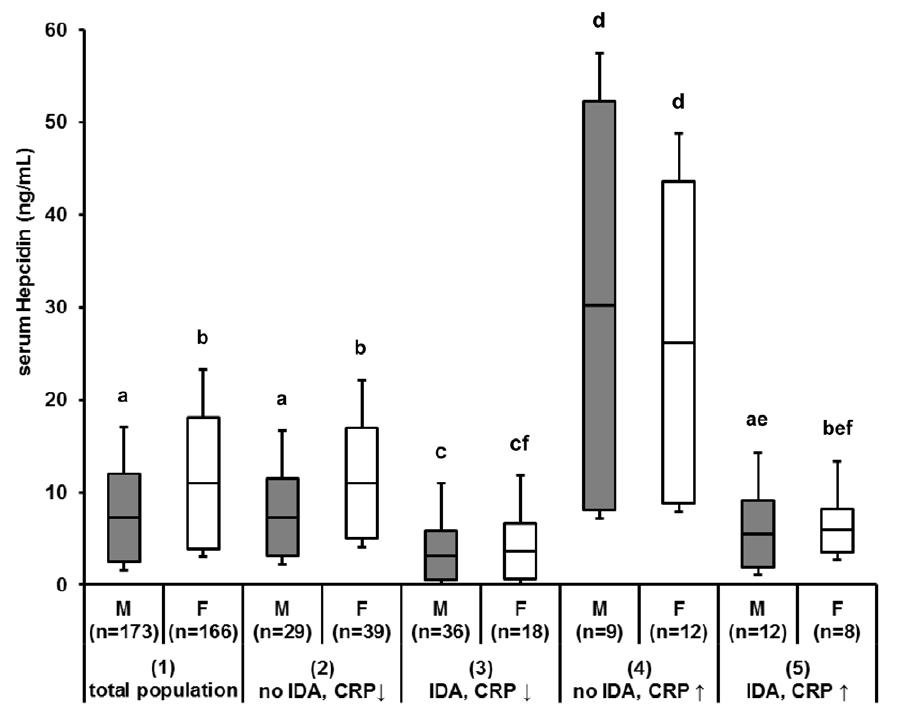
Figure 1. Median levels, lower and upper quartile plus standard error, of serum hepcidin (ng/mL) by sex, measured in different subgroups. Criteria for subgroups were as follows: ( 1 ) total population; ( 2 ) no iron deficiency (ID), no anemia, and no elevated CRP concentration; ( 3 ) ID and anemia (IDA), but no elevated CRP concentration; ( 4 ) no ID and anemia, but elevated CRP concentration; ( 5 ) IDA and elevated CRP concentration. Cut-offs were as follows: anemia: Hb , 110 g/L; ID: SF , 12 ng/mL or sTfR $ 7.4 mg/L; IDA: concurrent anemia and ID; no ID: SF $ 12 ng/mL and sTfR , 7.4 mg/L; elevated CRP: CRP $ 4.1 mg/L. Note: all individuals with ID and no elevated CRP were anemic. Letters (a, b, c, d, e, and f) indicate significant differences at P , 0.05.